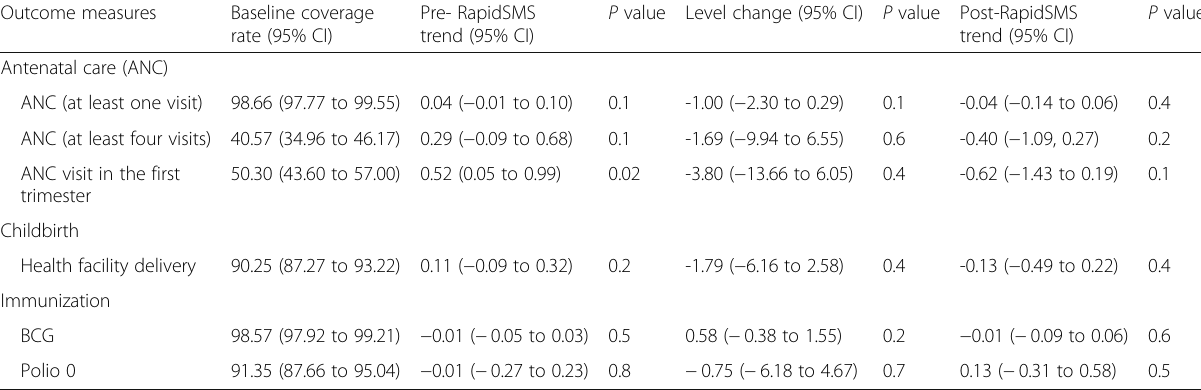
Table 2 Baseline coverage rate and change in level and trend for each outcome analyzed Outcome